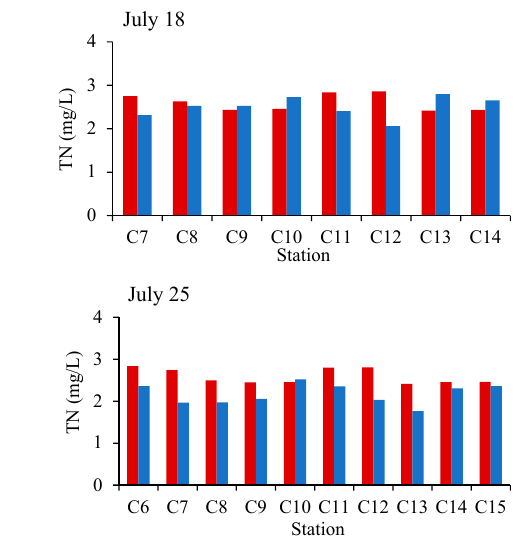
Figure 6. ( a ) The distribution of TN concentration during the brown tide period in May 2014. ( b ) The satellite-observed brown tide area in May 2014. 3.2. Function of Transfer from TN to A. anophagefferens A. anophagefferens is a tiny, spherical and nonmotile picoplanktonic (cell size 2–3 µm) pelagophyte with no flagella [18,45]. A. anophagefferens cells were abundant during the brown tide period in Qinhaungdao coastal waters, which can be seen as an indicator of brown tide. Zhang et al. [32] reported that A. anophagefferens abundance was strongly pos- itively correlated with nitrite and temperature. DON is commonly thought of as the main nitrite resource, and it is vital for improving A. anophagefferens -induced brown tide [46,47]. Due to nitrogen being the routine monitoring chemical element of river-input along the coastline in Qinhaungdao, we try to find the relationship between A. anophagefferens den- sity and TN concentration by means of the indirect transformation with DON. We analyzed the measured data from June 2013 to August 2014, which included two large-scale brown tide events (May 2013 and August 2014) in the sea area. According to the measured data, the A. anophagefferens cell density correlated with DON, and tempera- ture (T) shows a relatively obvious relationship. Figure 7 shows the relationship between the A. anophagefferens density (use the cells concentration to represent) and DON in 2013 and 2014 during the brown tide event periods. Commonly, a concentration of 5 × 10 7 cells/L is thought of as the warning indication value to represent brown tide, and we use red circles to mark these values in this figure. As shown in Figure 7a, the density of A. anophagefferens cells increases when the concentration of DON is in the range of 0.00 ~ 40.00 / L μ mol